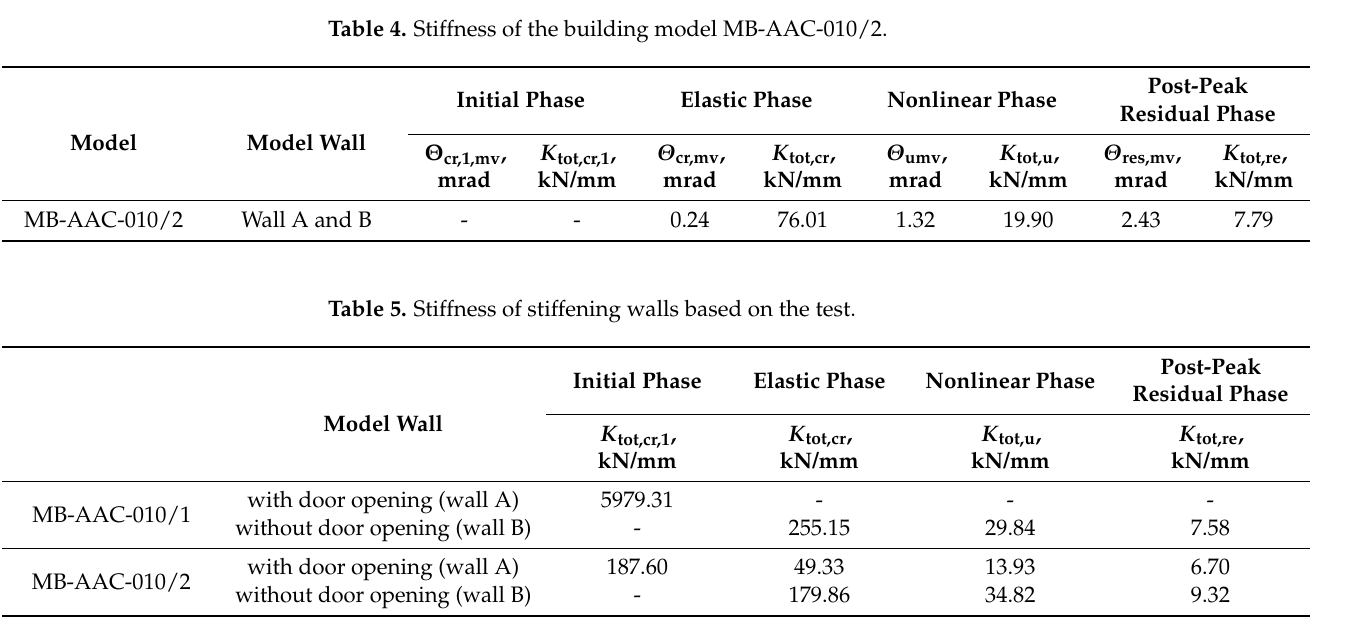
Table 4. Stiffness of the building model MB-AAC-010/2.